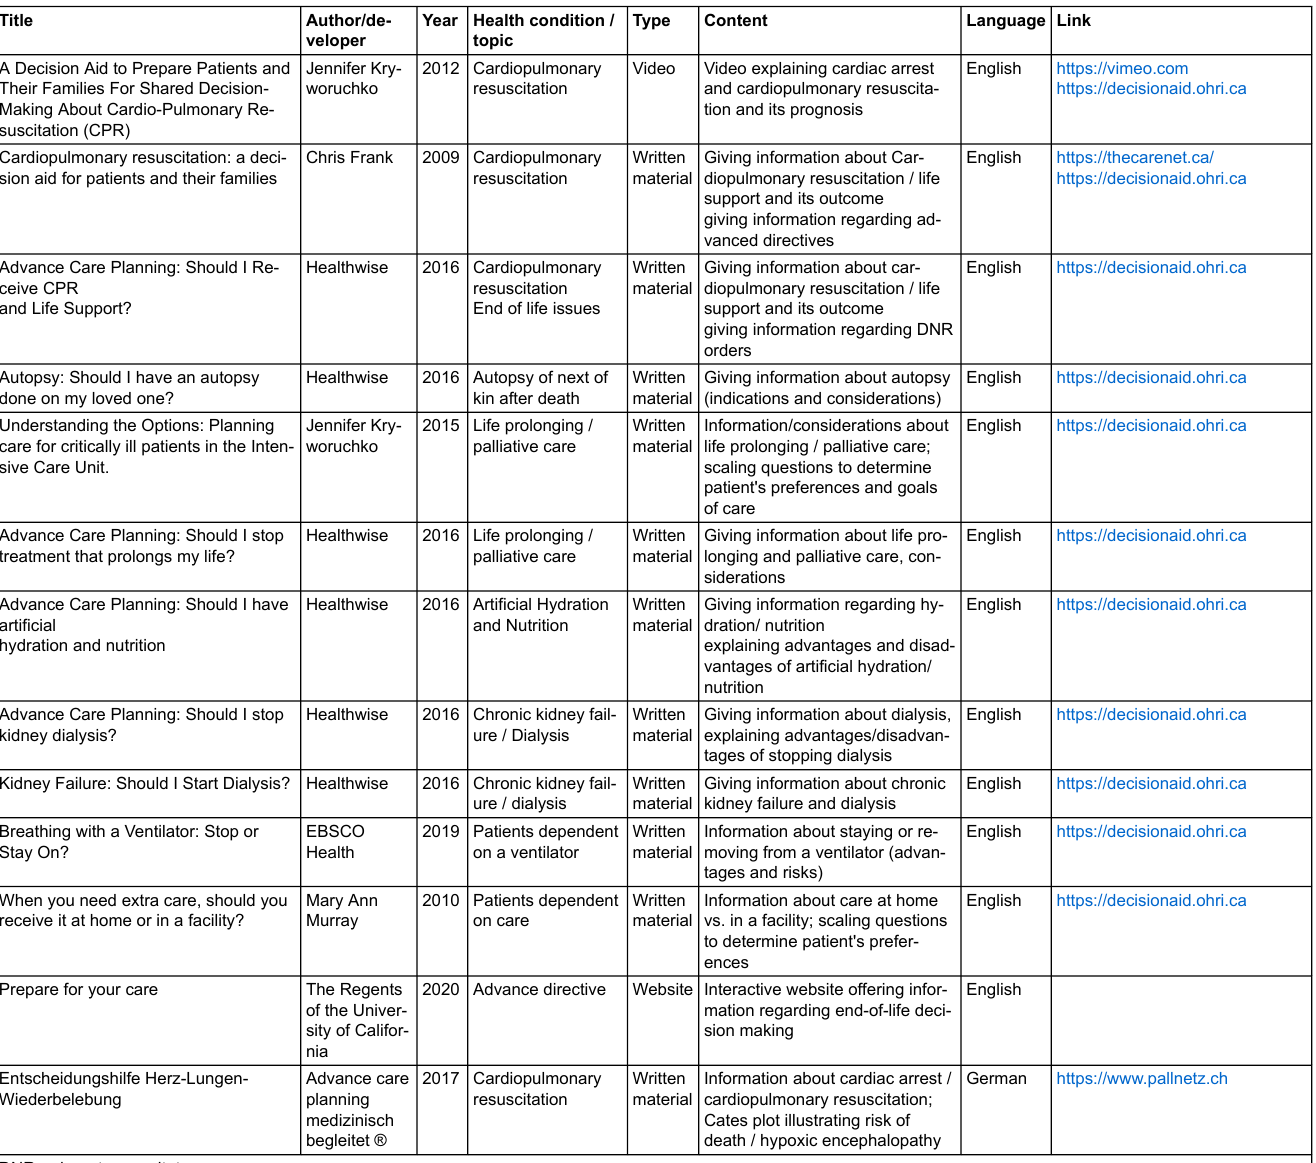
Table 3: Collection of decision aids for end-of-life